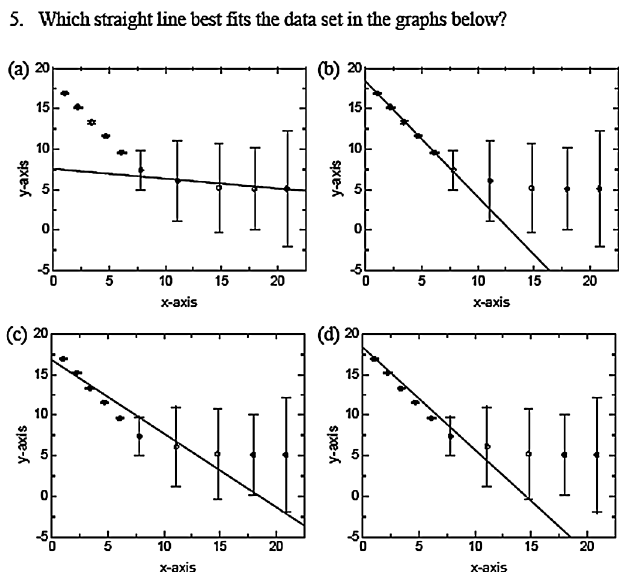
FIG. 5. Item 5 tests the student’s ability to interpret uncertainties displayed graphically and how they should be employed in weighting a straight line fit. The distractors include (a) the problem where students ascribe greater importance to the prominence of the data with larger error bars, (c) comes from striving to have an equal number of points above and below the line as well as touching the error bars of the least important, but most prominent, data, and (d) which is close to a correct weighting, but still gives too much weight to the poorest data. A chi-square statistic of the numerical data clearly shows that fit (b) is best. These data might seem contrived but can actually be produced under very natural circumstances. For example, a semilog plot of the voltage decay across a capacitor in a RC circuit [i.e., ln ð V Þ versus t ] results in data and error bars of this sort.